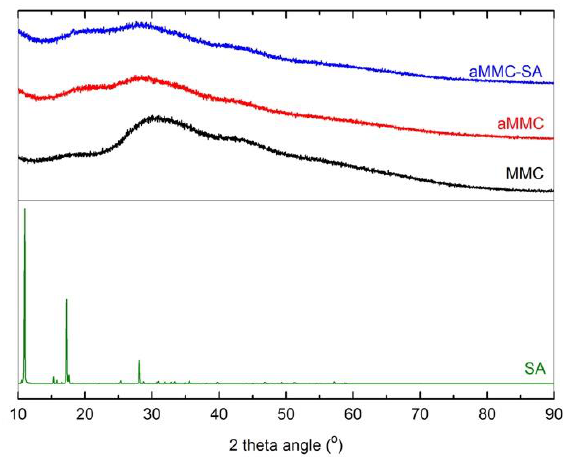
Figure 3. XRD patterns for MMC, aMMC, aMMC–SA, and pure SA.